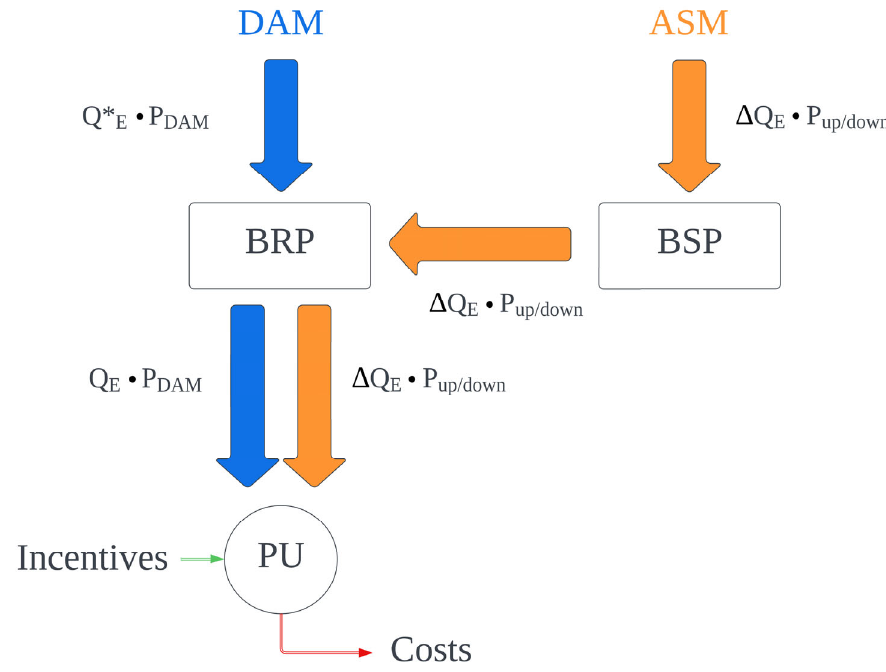
Figure 7. Economic flows of the PU participating in the DAM and ASM. When participating in the ASM, the PU is remunerated for the regulation supplied ∆ Q E (MWh) at prices P up and P down ( € /MWh), respectively, for upward and downward power variations. In addition, in this case, the effect of possible power imbalances is